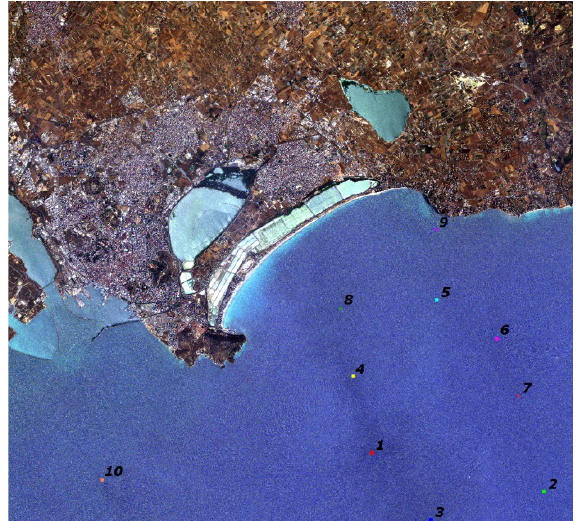
Figure 1. Distribution of the Areas of calibration in the 5318